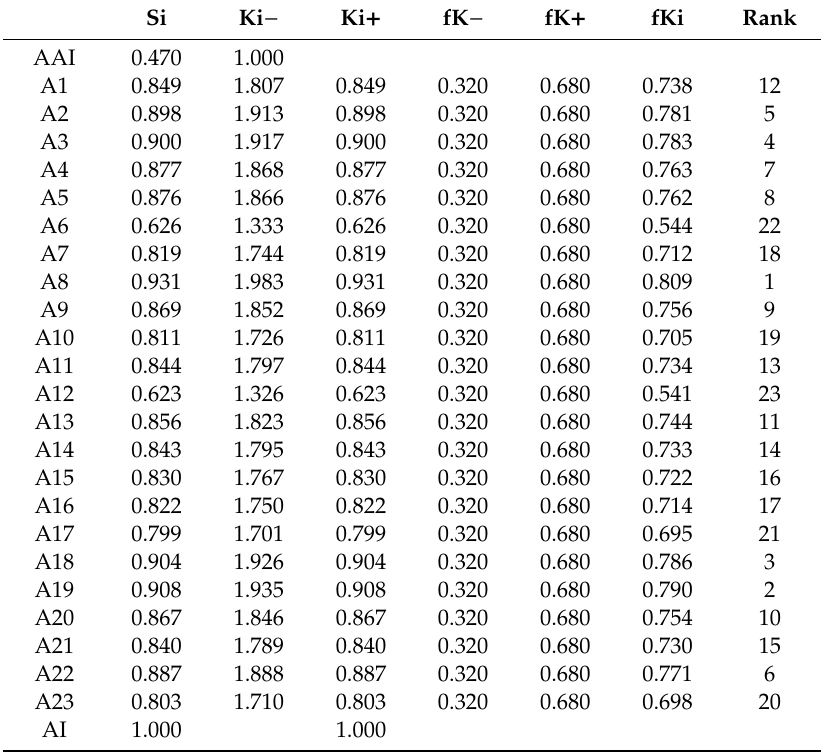
Table 5. Results of MARCOS